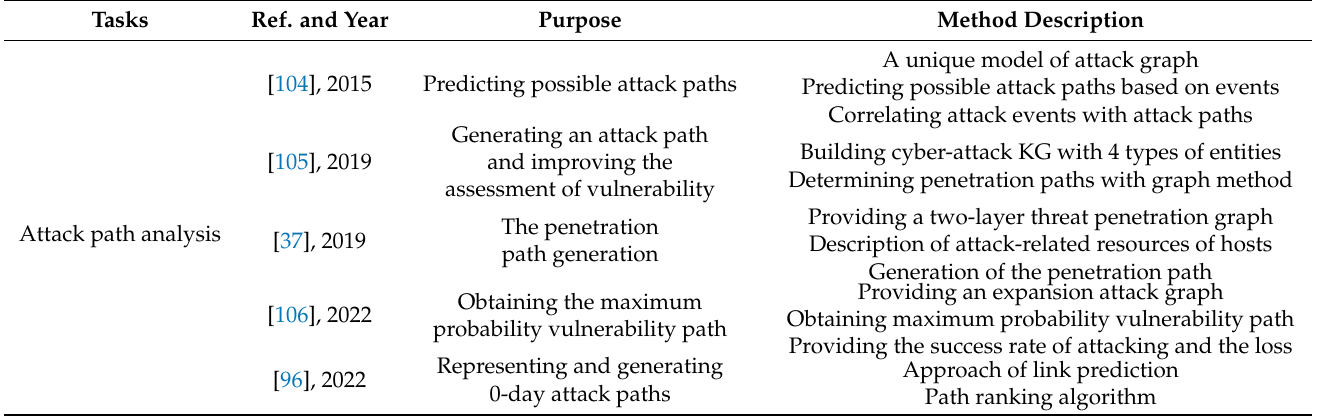
Table 5. The knowledge graph’s application in attack investigation task.